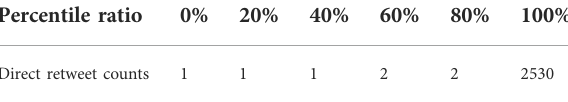
TABLE 1 Quantile of the count of users being directly